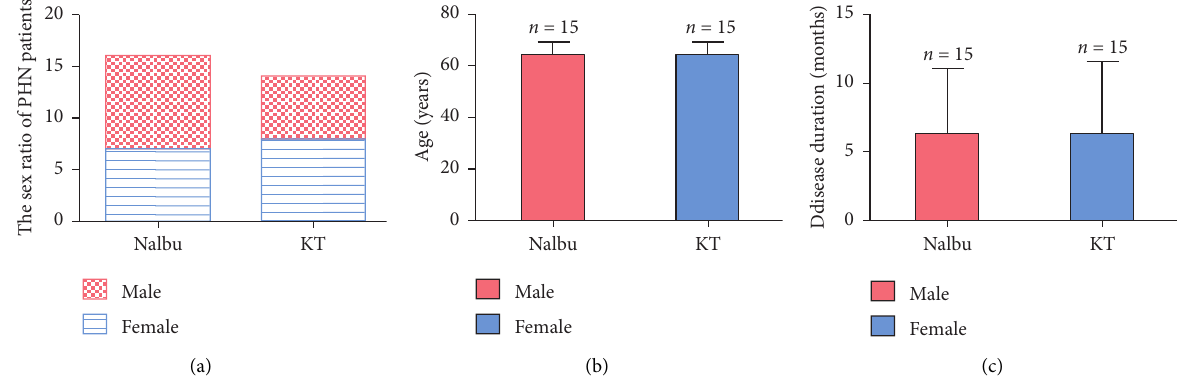
Figure 3: General information of patients between two groups. (a) The sex ratio of PHN patients; (b) age of patients; (c) disease duration of patients. Nalbu, nalbuphine; KT, ketorolac tromethamine. n � 15 for each